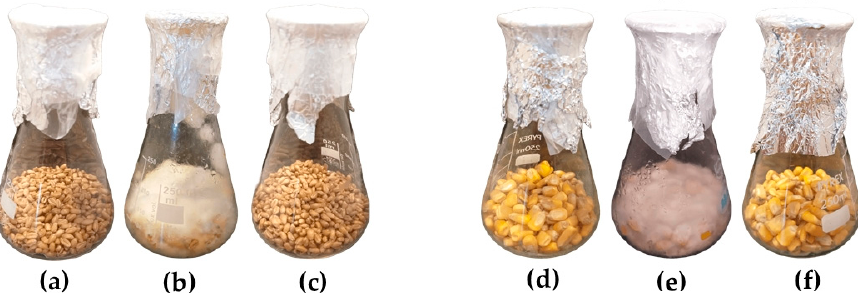
Figure 4. Effect of the application of T. gallica bark extract on the growth of F. graminearum : ( a ) negative control wheat grains, ( b ) positive control wheat grains, ( c ) wheat grains inoculated with F. graminearum and treated with T. gallica bark extract at a dose of 375 μ g·mL − 1 , ( d ) negative control maize grains, ( e ) positive control maize grains, ( f ) maize grains inoculated with F. graminearum and treated with T. gallica bark extract at a dose of 375 μ g·mL − 1 . Only one replicate per treatment is shown.